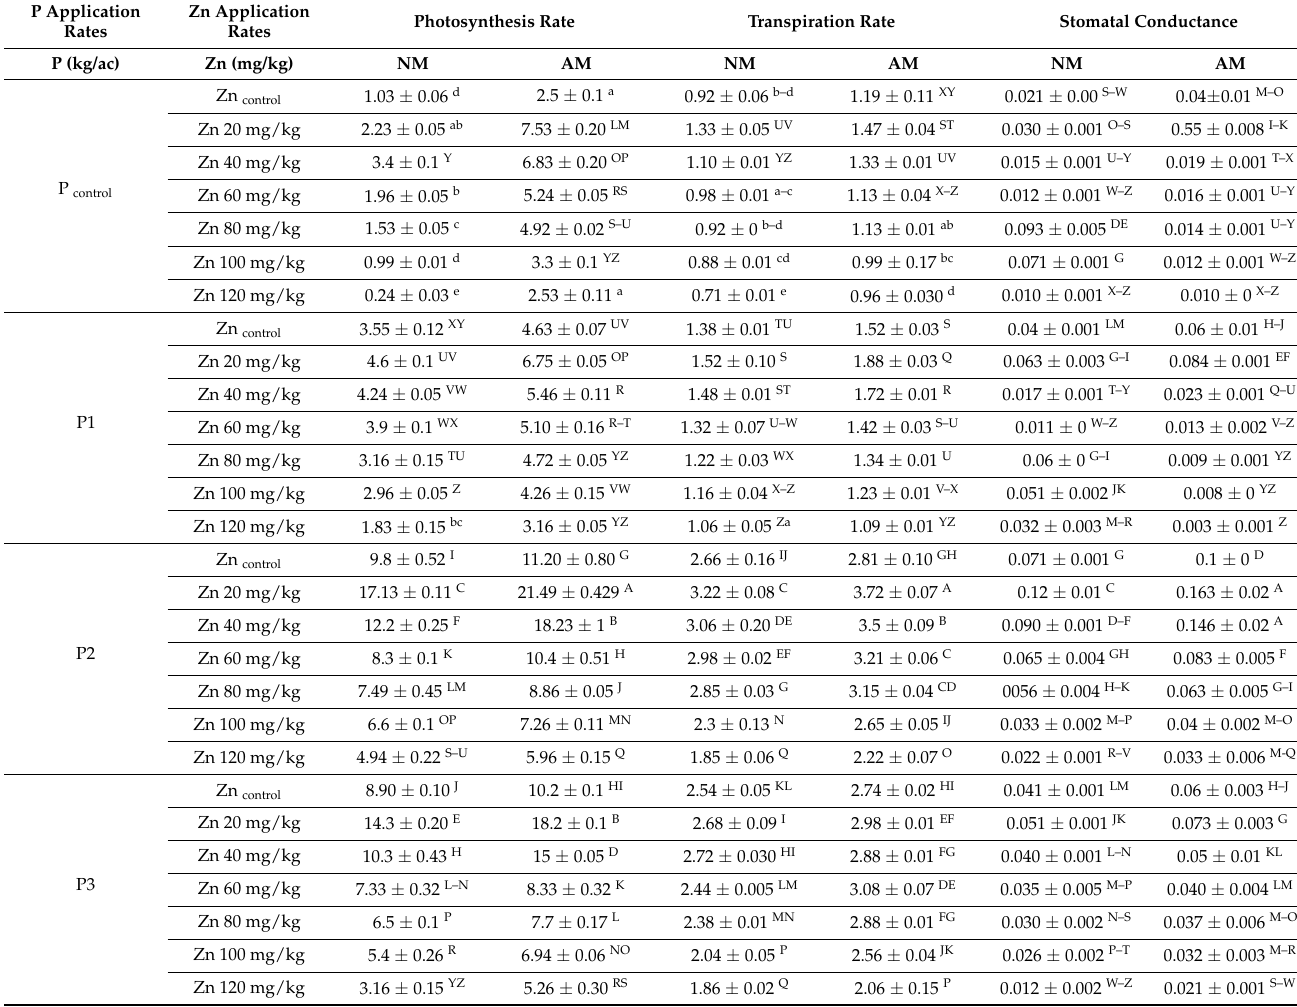
Table 6. Photosynthesis rate, transpiration rate, and stomatal conductance rate of AMF inoculated (AM) and non-inoculated (NM) plants grown under various P (0 to full recommended dose) and Zn (0–120 mg Zn/kg soil) application rates. Mean values are presented ± standard error (SE). Different letters show significant difference at p ≤ 0.05. Capital letters indicate the highest values. After completely using upper case letters up to Z, lower case letters are used to show the decrease of mean